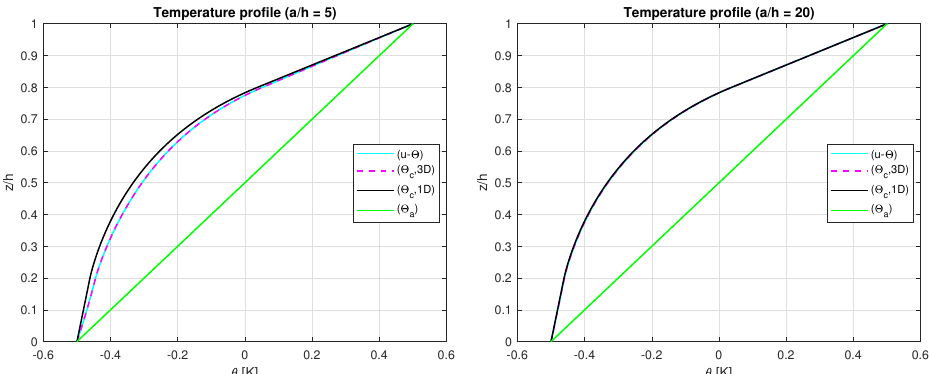
Figure 3. First benchmark, temperature profiles for thick and moderately thick simply supported sandwich square plates with FGM ( p = 0.5) core. The maximum amplitude of the temperature θ ( α , β , z ) is evaluated at the centre of the plate ( a /2, b /2).